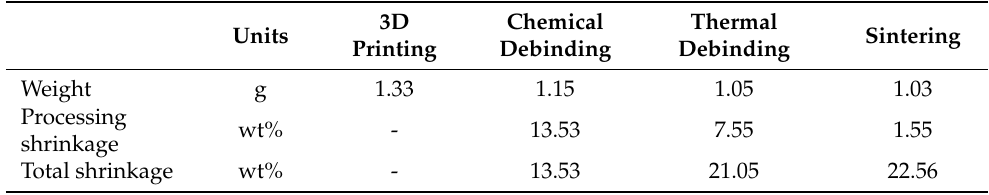
Table 5. Part with an internal gyroid structure: (a) Printing on FFF technology, (b) Chemical debinding, (c) Thermal debinding, (d) Sintering